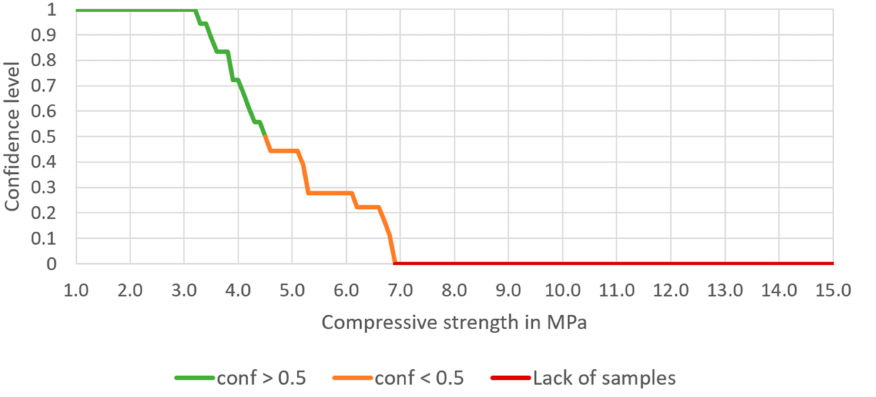
Figure 7. The dependence of the confidence of the rule on the chosen compressive strength, based on selected aggregate mixture and 6% cement content.